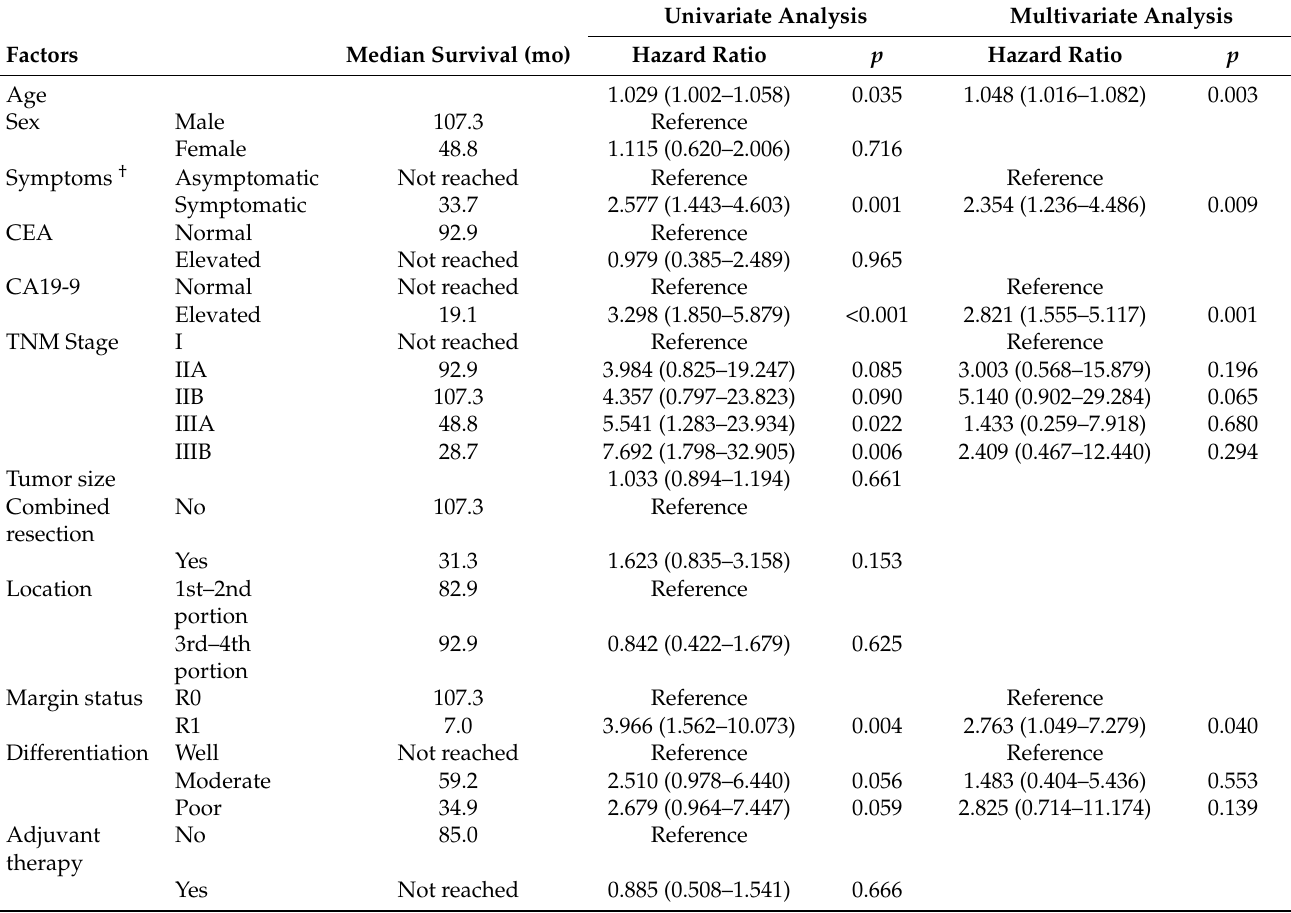
Table 3. Uni- and multivariate analysis identifying factors affecting patients’ survival ( n = 109). Univariate Analysis Multivariate Analysis